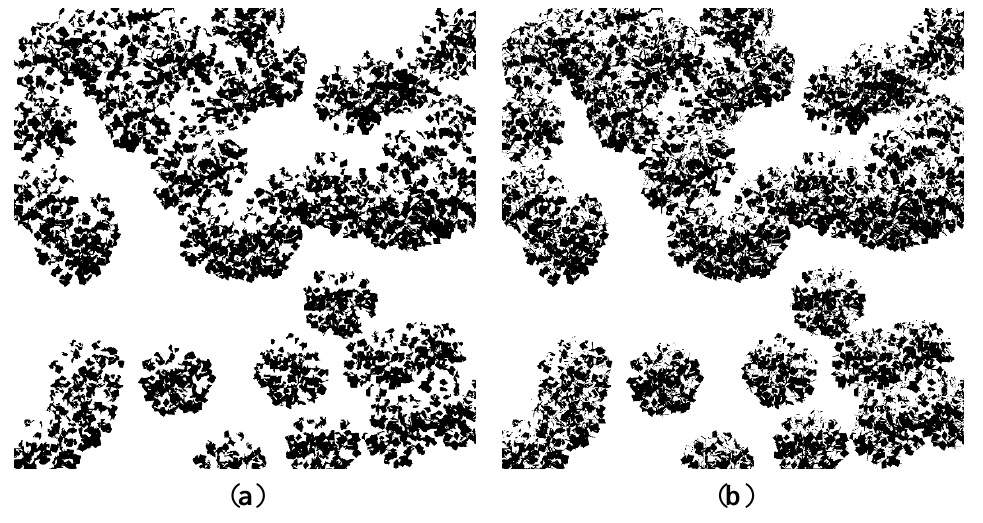
Figure 4. The classification results of sunlit foliage (in black) and background (in white) by the automated LAB2 algorithm ( a ) and by the 3D software ( b ). The original RGB image was acquired at nadir view ( θ = 0° ) as in Figure 3b. 𝑣